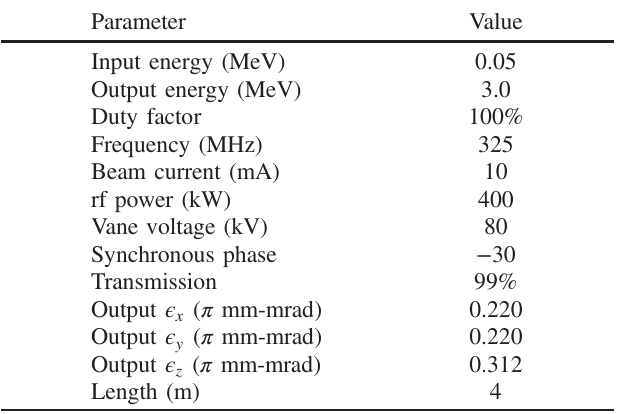
TABLE III. Final RFQ parameters.